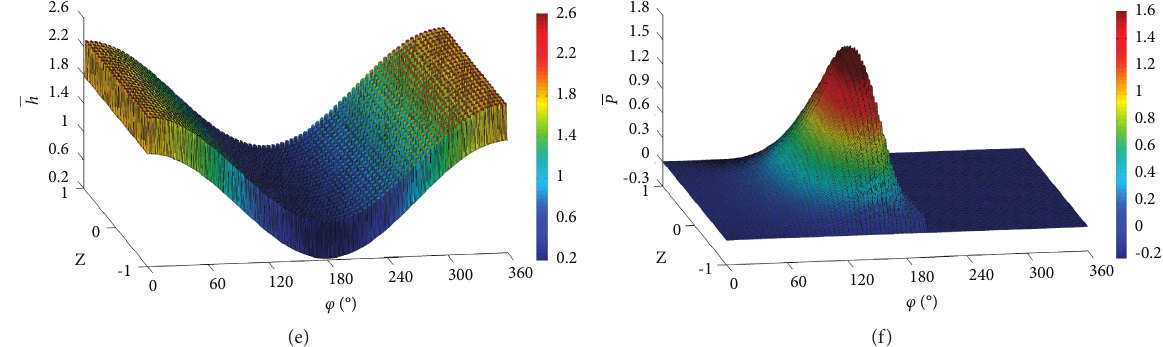
Figure 3: The dimensionless fluid film thickness h and fluid film pressure P : (a-b) smooth journal bearing; (c-d) partially textured journal bearing; (e-f) fully textured journal